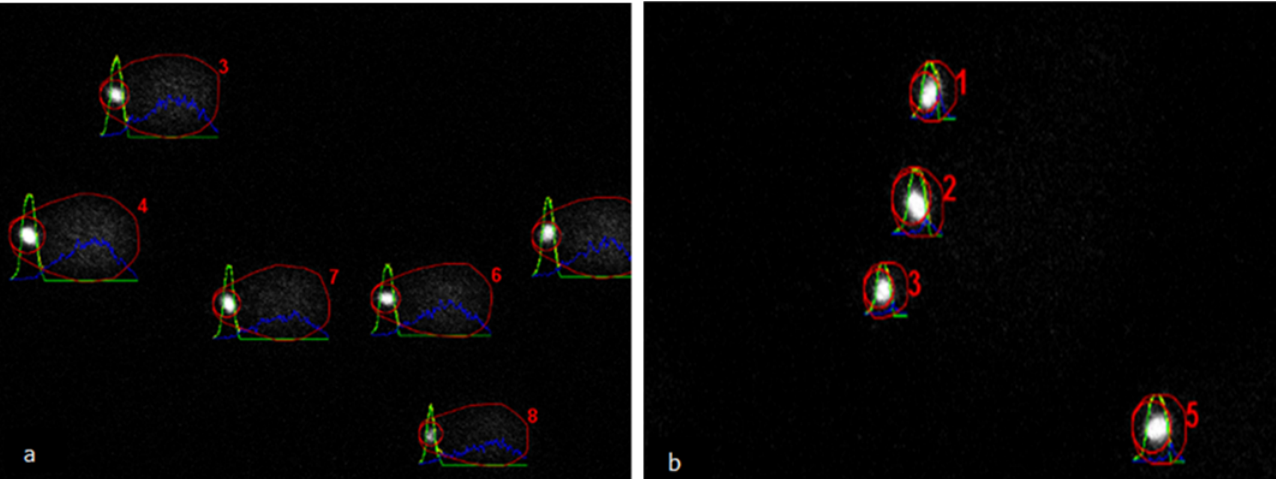
Figure 2. Images of the alkaline comet assay analyzed using Open comet software. ( a ) Raw semen sample containing DNA-damaged spermatozoa. ( b ) Band2 from a modified flotation DGC (top layer Opti-prep TM 20% diluted semen mixed with Opti-prep TM 60% and bottom layer Opti-prep TM 40%) with spermatozoa without DNA damage. Red outline and number (regular comet suitable for evaluation), green profile (comet head), yellow profile (comet tail) and blue profile (comet equal to head plus tail) (full details at https://cometbio.org/documentation.html#interface, accessed on 30 June 2021).